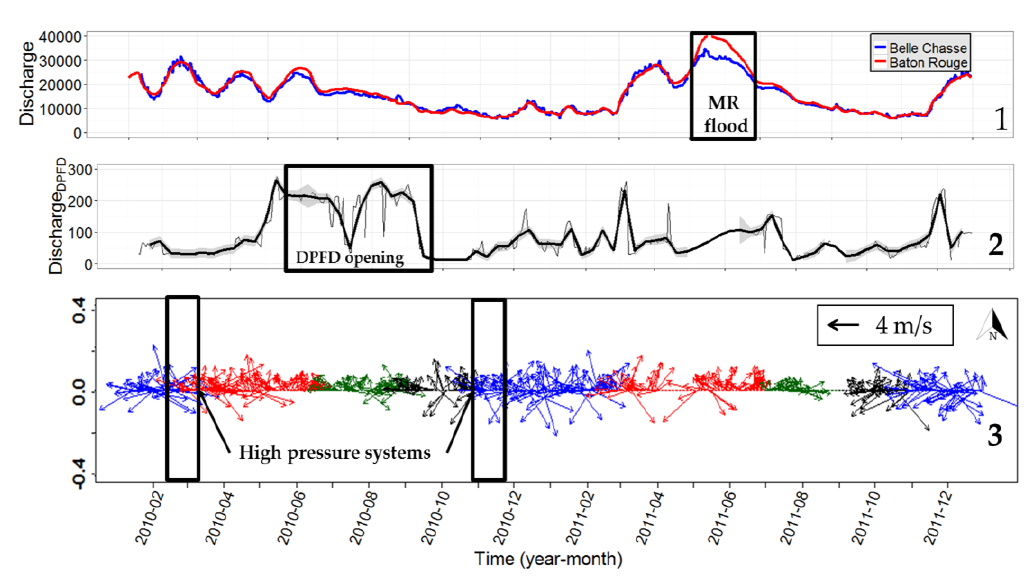
Figure 2. Mean daily discharge (m 3 ∙s −1 ) of the Mississippi River at Baton Rouge (red line) and Belle Chasse (blue line) ( 1 ), mean daily discharge (m 3 ∙s −1 ) at Davis Pond Freshwater Diversion (DPFD) ( 2 ), mean daily wind speed (ms −1 ) and mean daily wind direction (in degrees from the North) ( 3 ). Black boxes represent the MR flood—The Mississippi River flood condition (May 2011) (1), DPFD opening—A large amount of freshwater release